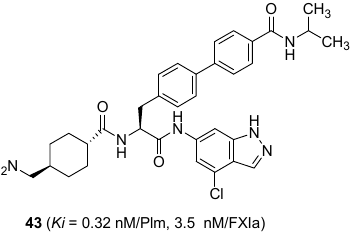
Figure 4. Structure of compound 43 [41] developed by Bayer AG.